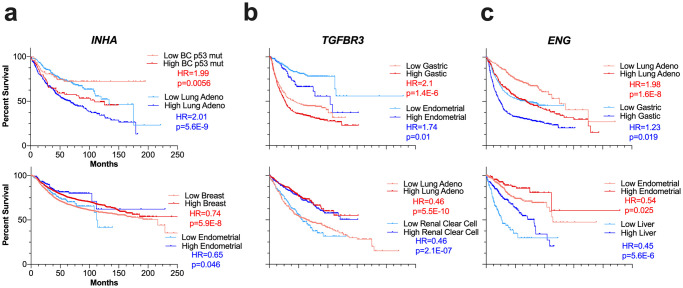
Representative Kaplan Meier curves for INHA, TGFBR3, and ENG.Event-free survival in indicated cancers using median to separate expression (lighter shade indicates bottom patients expressing bottom 50% and darker shade top 50%). Survival curves represent OS for all cancers except breast cancer (RFS) and ovarian cancer (PFS). Top plots show cancer types where the gene is a negative predictor of survival, and bottom plots show cancer types where the gene is a negative predictor.